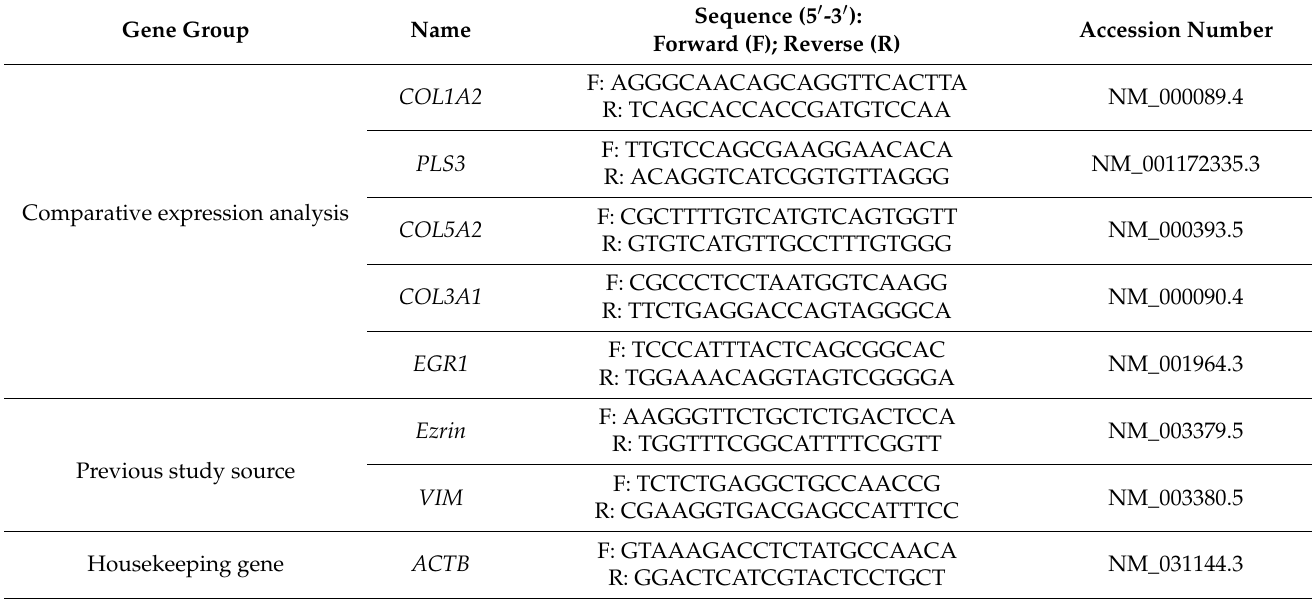
Table 1. Real-time PCR primer